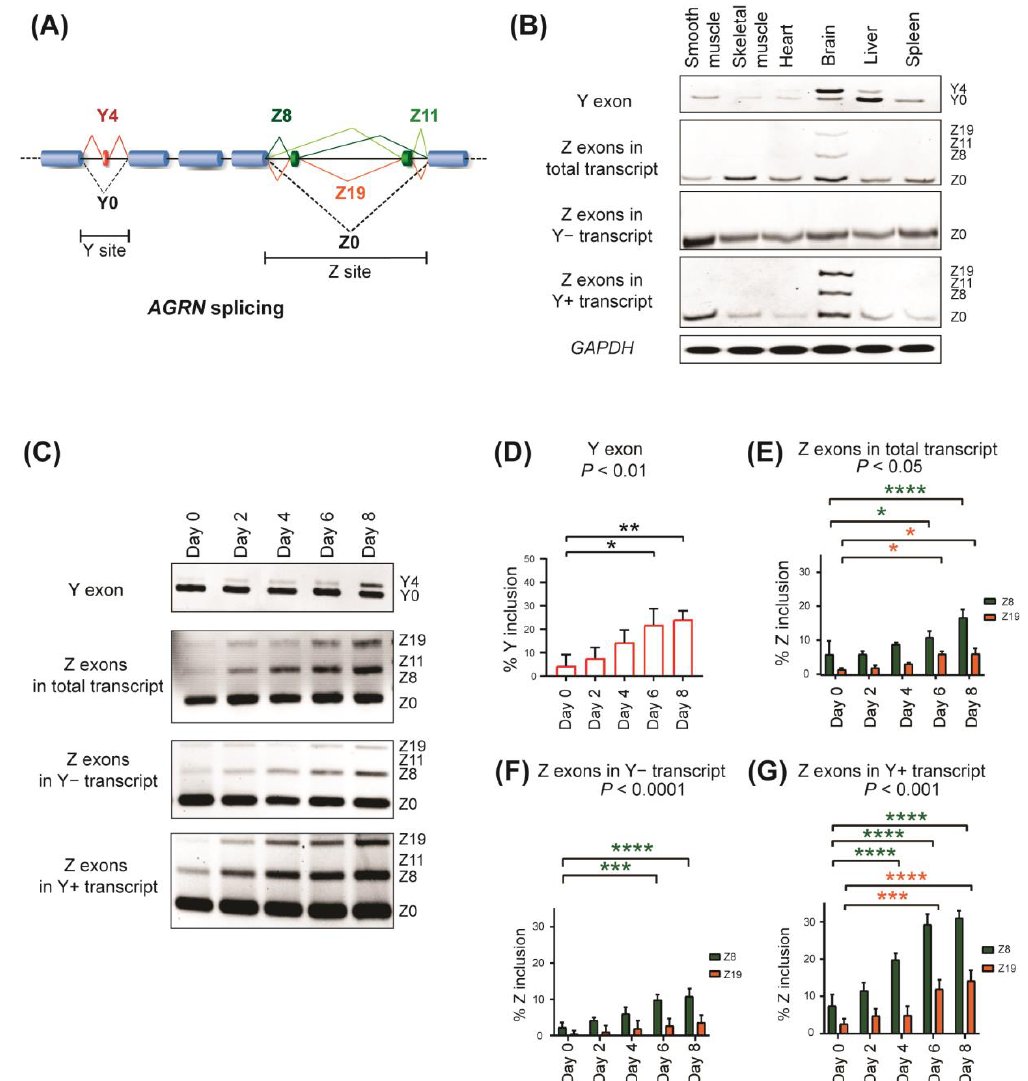
Figure 1. Alternative splicing of human AGRN . ( A ) Schematic showing alternative splicing patterns of AGRN at the Y and Z sites. ( B ) RT − PCR showing alternative splicing of Y and Z exons in various human tissues. ( C ) RT − PCR showing alternative splicing of endogenous Y and Z exons in SH − SY5Y cells in the course of neuronal differentiation. ( D – G ) Quantification of ( C ). Percent of Y exon inclusion (%Y inclusion) is shown in ( D ). Z exon inclusion (%Z inclusion) from total transcript, Y − transcript, and Y+ transcript is shown in ( E – G ), respectively. Mean and SD ( n = 3 independent experiments) are indicated. p − values of one − way ANOVA ( D ) and two − way ANOVA ( E – G ) are indicated above the graphs. * p < 0.05, ** p < 0.01, *** p < 0.001, and **** p < 0.0001 using Tukey’s post hoc test compared to day 0 when